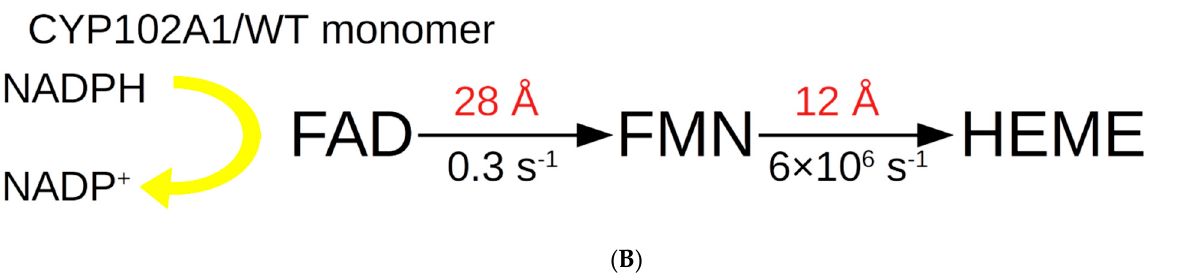
Figure 1. ( A ) Alignment of experimental structures of individual domains to predicted CYP102A1/WT structure (green): heme (PDB ID: 1BVY; yellow), FMN-domain (PDB ID: 1BVY; cyan) and FAD-domain (PDB ID: 4DQK; grey) on the structure of the CYP102A1/WT monomer obtained in AF2. Spheres show crystallised heme (pseudo colours, yellow carbon atoms), FMN (pseudo colours, cyan carbon atoms), FAD (pseudo colours, grey carbon atoms). ( B ) Schematic diagram of electron transport in the electron transport chain of the CYP102A1/WT monomer.